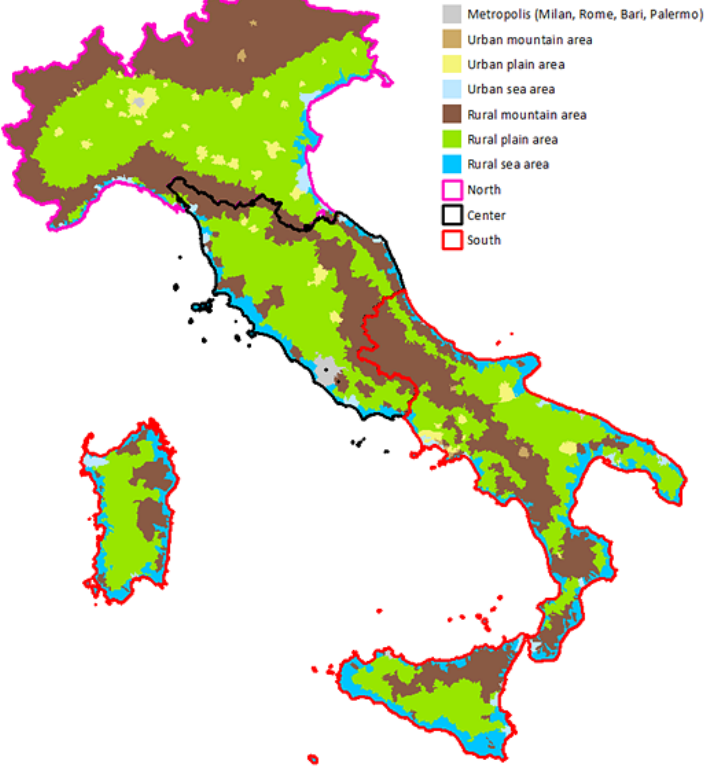
Figure 1. The 21 geographic clusters, identified based on ISTAT geographic and administrative criteria. ISTAT: Italian National Statistics Institute.